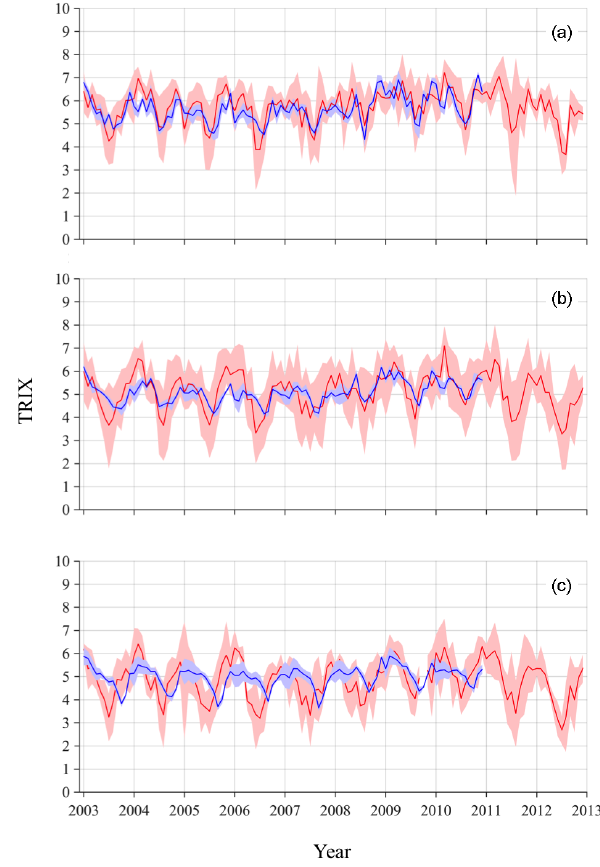
Figure 2. Comparison between in situ TRIX (red line) and model TRIX (blue line) averaged over the three study areas (A, B, and C). Model TRIX was calculated using U i and L i values extracted from the numerical simulations relative to the period 1982–1993. Red and blue shaded areas correspond to average values ± 2 standard